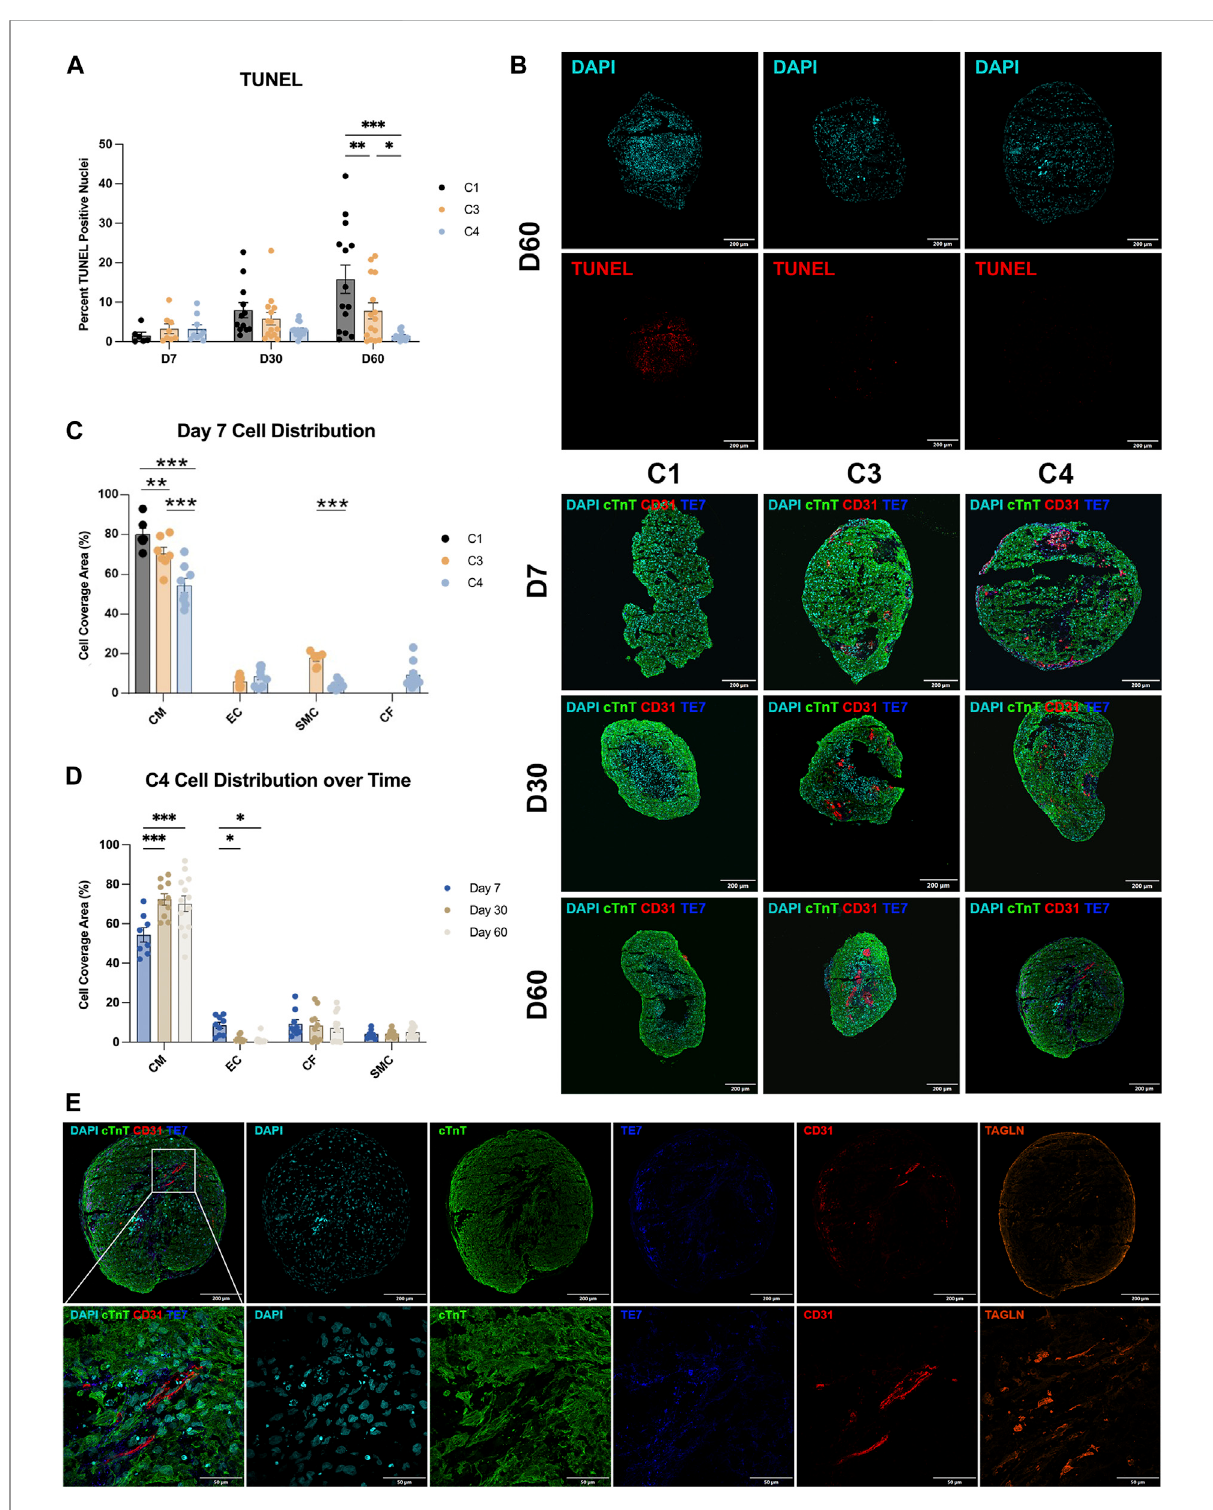
FIGURE 3 Apoptosis and cell-occupancy measurements. (A) C1, C3, and C4 spheroids were collected at the indicated time points and cut into 10-µm sections; then, the surface areas of every 10th section were measured, and the centermost section (i.e., the one with the largest surface area) was TUNEL-stained. Nuclei were counterstained with DAPI, and apoptosis was quanti fi ed as the percentage of TUNEL-positive cells. Representative images are displayed for the centermost sections from each group on D60. (B) Centermost sections were stained with cTnT, CD31, and TE-7